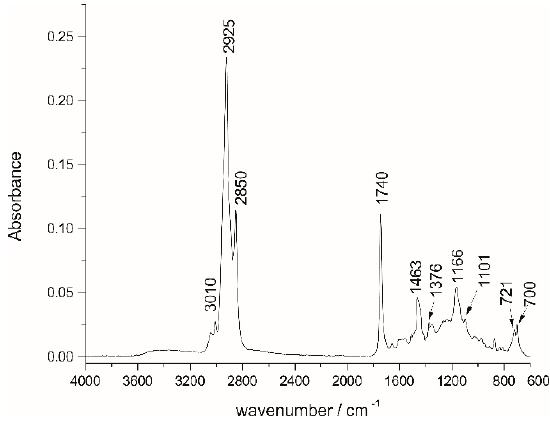
Figure 6. FTIR spectrum of thermochromic ink.